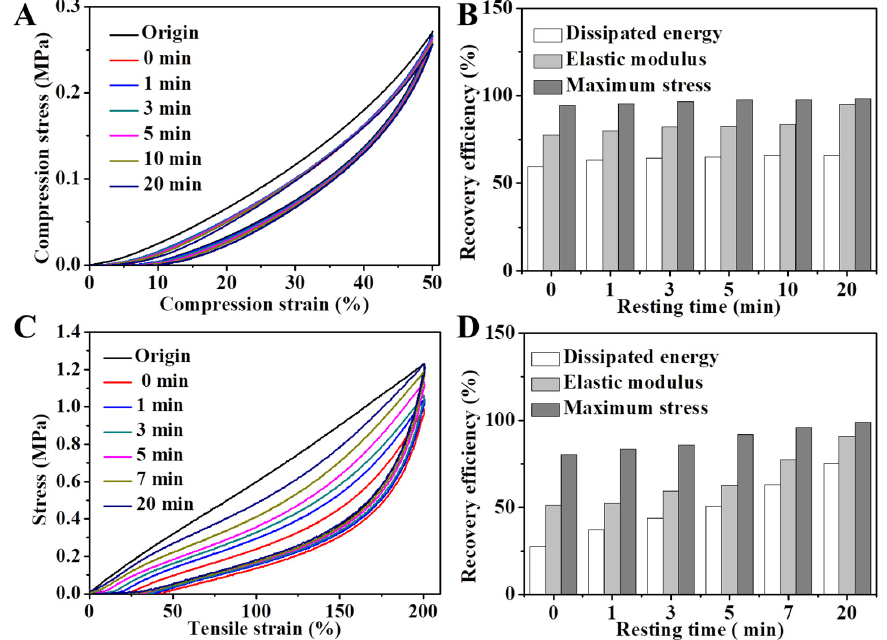
Figure 4. ( A ) Self-recovery behavior and ( B ) self-recovery efficiency upon compression. ( C ) Self-recovery behavior and ( D ) self-recovery efficiency upon elongation.